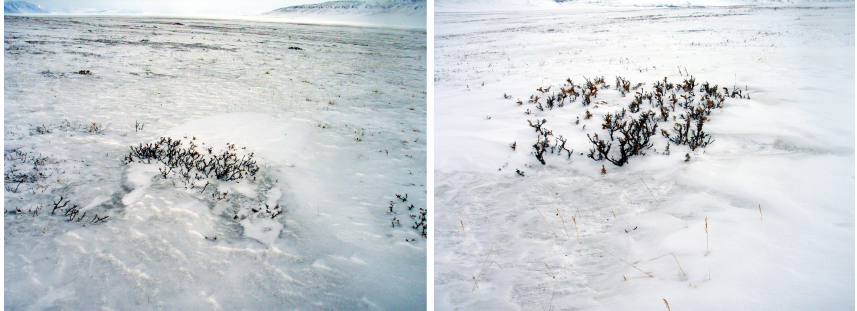
Figure 3. Photographs of snow-trapping by willows in May 2014, near the “scattered willows 1” site. Increased snow height caused by the presence of shrubs is obvious. On both pictures the contrast has been enhanced with photographic modification software.